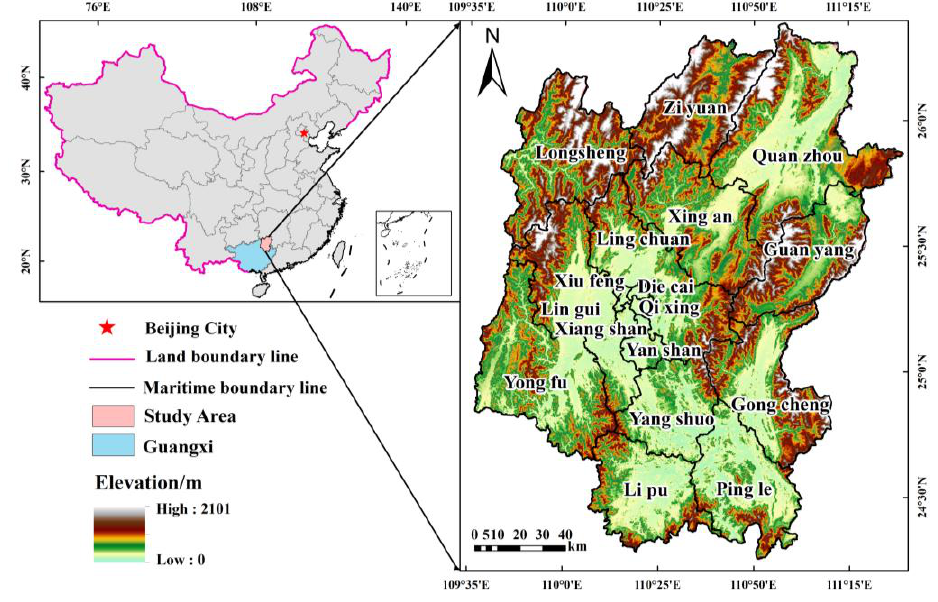
Figure 1. Location of the study area.